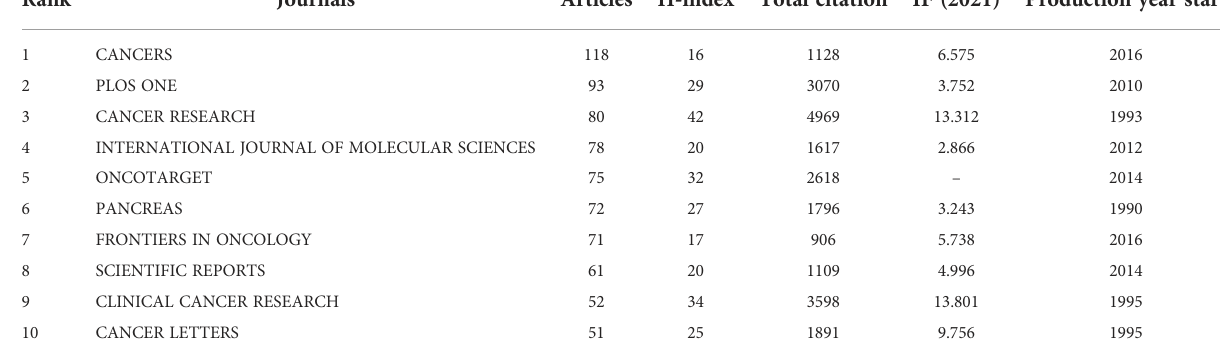
TABLE 4 The top 10 core journals in the fi eld of pancreatic cancer metabolism. Rank